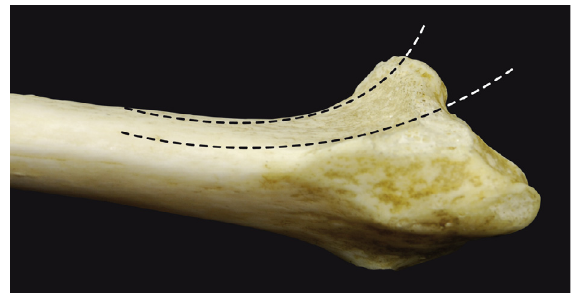
Figure 6. An oblique view of the distal radius showing the wrist columns (medial and